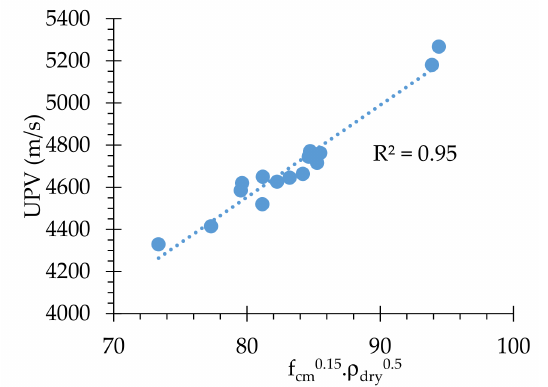
Figure 22. Ultrasonic pulse velocity, UPV, of concrete as a function of compressive strength, f cm , and dry density, ρ